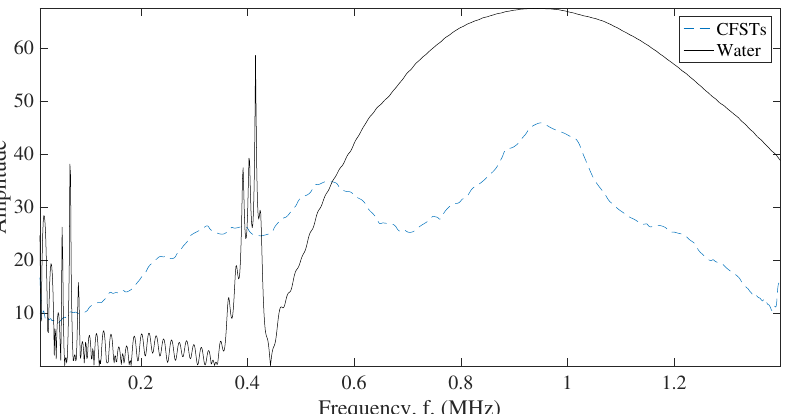
Figure 4. Representation of frequency spectra of reference material (degassed water) and CFST sample (dashed